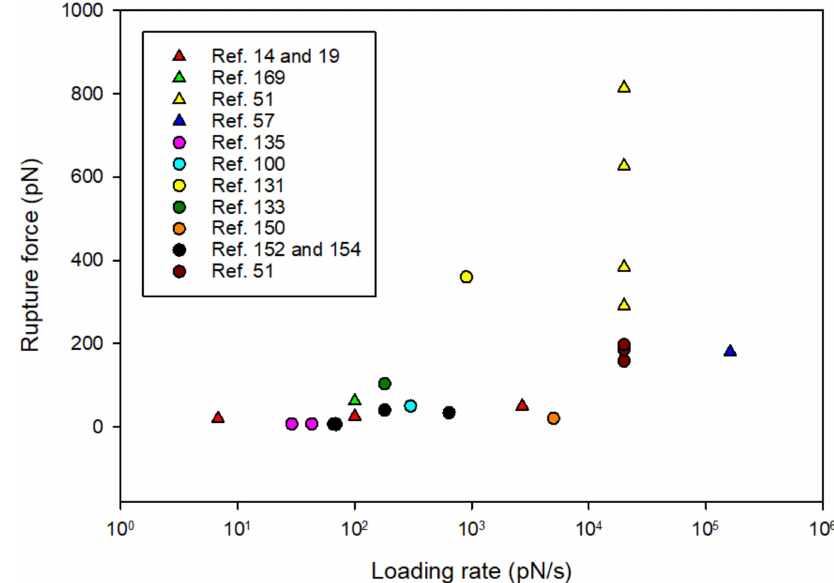
Figure 6. Comparison of the strength of bacterial surface adhesion as well as molecular pair interactions. The quantitative data presented in the figure is extracted from the papers presented in Table 1. The quantitative data extracted from studies on single bacterium—substrate interactions are presented using triangles whereas the data on single molecule interactions are presented using